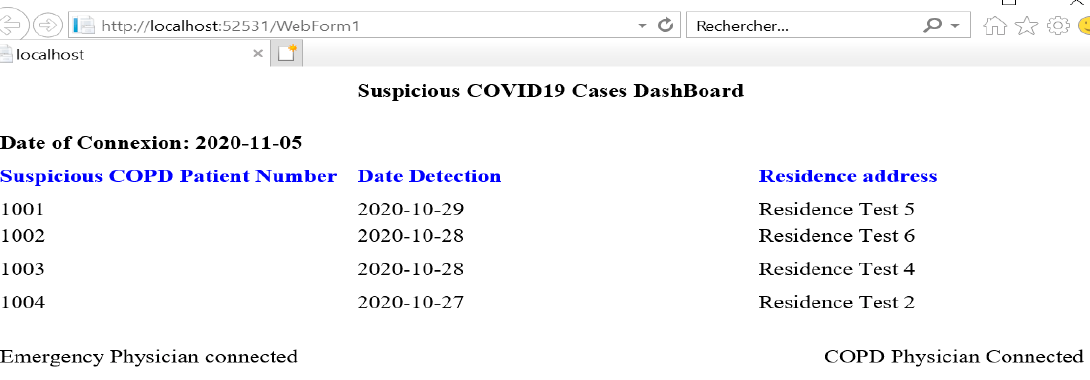
Figure 21. Adaptative dashboard of suspected cases.